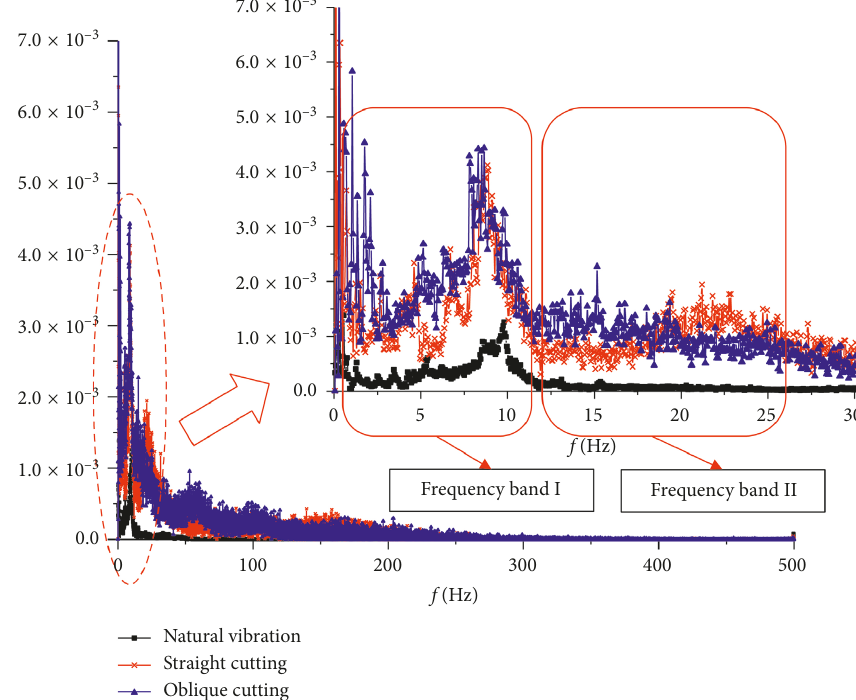
Figure 3: Hilbert spectrum of the vibration